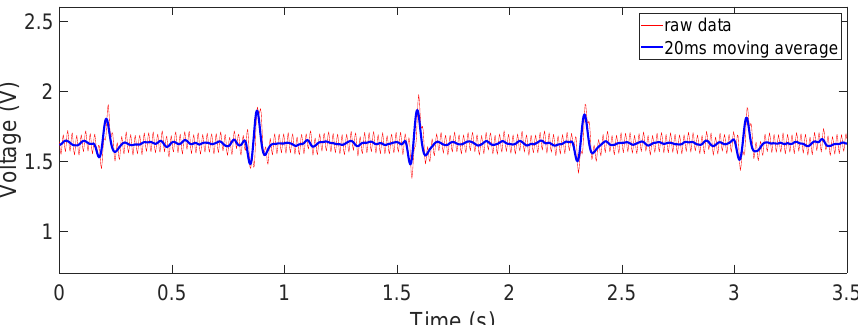
Figure 9. Non-contact ECG output: on chest, through dry cotton.